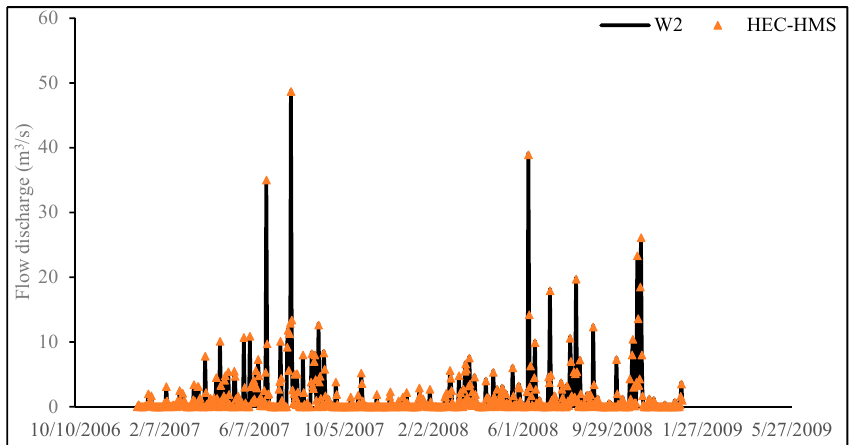
Figure 14. Comparison of W2 modeled and observed flow discharge.